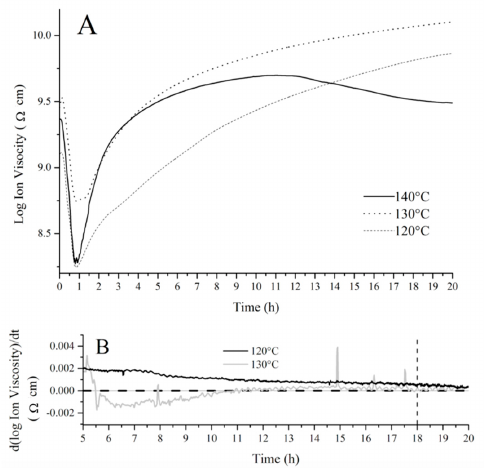
Figure 5. ( A ) DEA curves of fatty acid resin cured at 120, 130, and 140 °C for 20 h; ( B ) Derivative of the DEA curves of the fatty acid resin cured at 130 and 120 °C with respect to